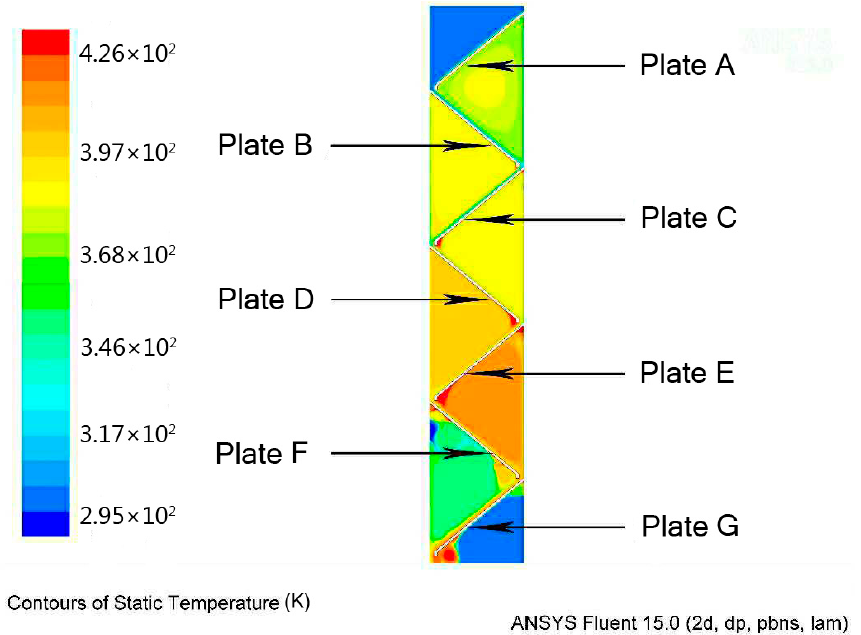
Figure 11. Internal temperature cloud of the new moving bed coal moisture control device.